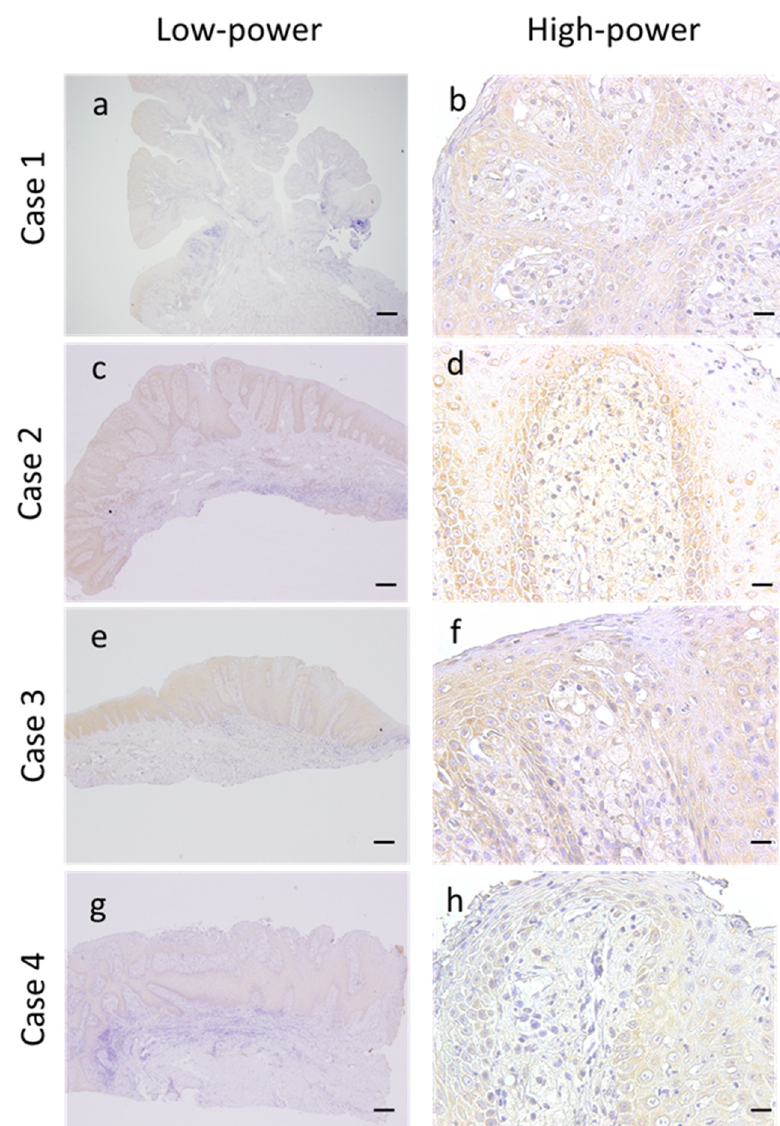
Figure 4. Vascular endothelial growth factor (VEGF) immunostaining in oral verruciform xanthoma. Representative VEGF images of oral verruciform xanthomas. ( a , c , e , g ) Low-power view of VEGF images. The expression level of VEGF in the epithelium of OVX was equal to that of the corresponding normal epithelium in all patients (scale bar, 1000 µ m; original magnification; 12.5 × ). ( b , d , f , h ) High-power view of VEGF images. VEGF also exhibited positive staining in the foamy macrophages in all patients. However, in Case 4, the immunoreactivity was weaker than that in other cases (scale bar, 20 µ m; original magnification, 400 ×